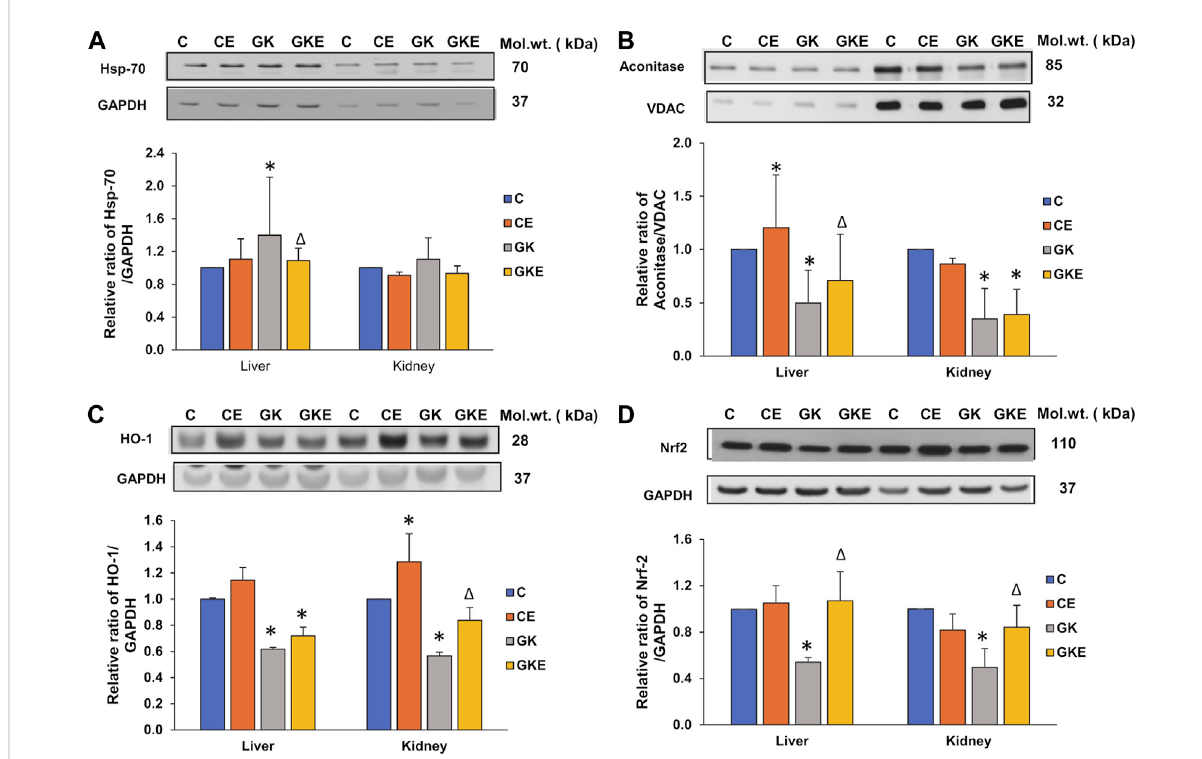
FIGURE 6 Exercise-induced alterations in the expression of oxidative stress marker proteins in the liver and kidney of control Wistar (C) and diabetic GK (GK) and exercise-trained control (CE) and GK (GKE) rats ( n = 5). Cellular fractions were electrophoretically separated by 7.5% – 12% SDS-PAGE, transferredontonitrocellulosemembranes,andimmunoblottedwithstress-sensitivemarkerproteins,Hsp-70 (A) ,mitochondrialAconitase (B) ,HO- 1 (C) and Nrf2 (D) and visualized using theSapphire Biomolecular Imager (Azure Biosystems, Dublin, OH, United States) or by exposure to X-ray fi lms. GAPDH and VDAC were used as loading controls for cytosolic and mitochondrial fractions respectively. Immunoreactive bands were quantitated using Image Studio Lite, ver.5.2 (LI-COR Biosciences, Lincoln, NE, United States). Histograms represent the relative ratio of protein over their respective loading controls from three independent experiments. Statistical signi fi cance is shown as asterisks, which was fi xed as p < 0.05 (* indicates statistical signi fi cance compared with control Wistar rat tissues while Δ indicates statistical signi fi cance compared with diabetic GK rat tissues). Molecular weights of the respective proteins are indicated in kDa. Original western blot fi gures are shown in the Supplementary Figure